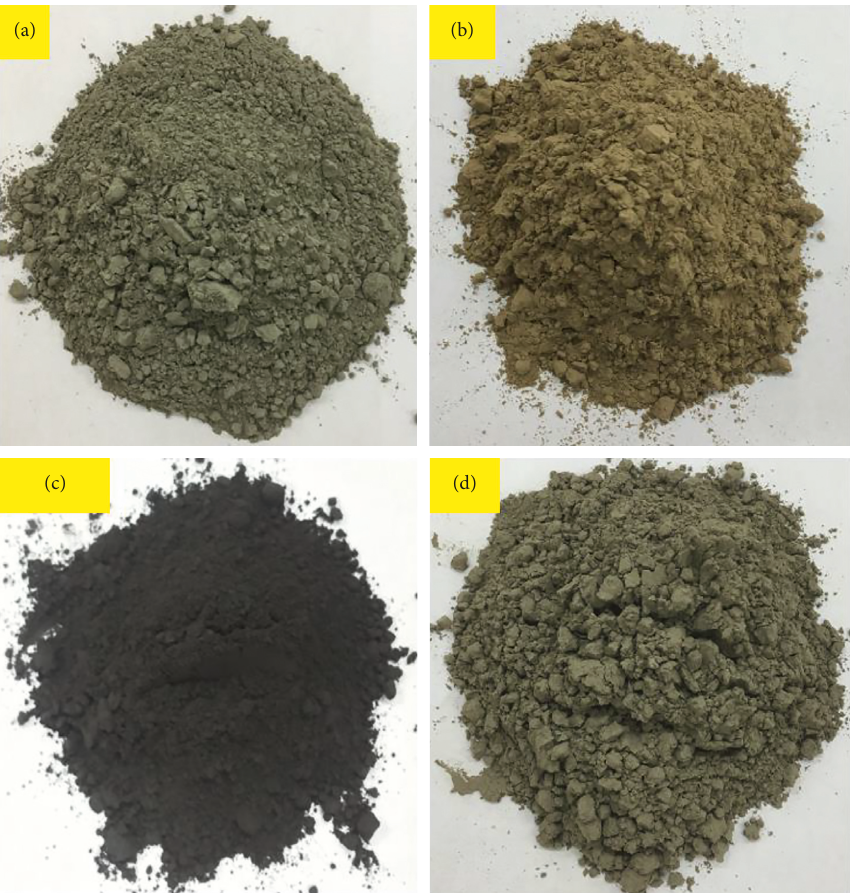
Figure 3: Pozzolanic and cementitious materials in their powder form: (a) cement (C); (b) fly ash (FA); (c) electric arc furnace slag (EAFS) 100% pass 45-micron sieve; (d) volcanic ash (VA) 100% pass 20-micron sieve.